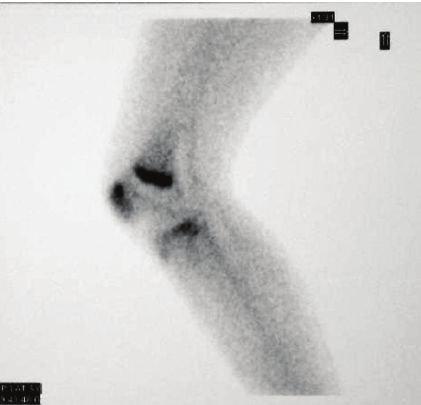
Figure 2: Three-phase scintigraphy showing a picking up area on the superior part of the